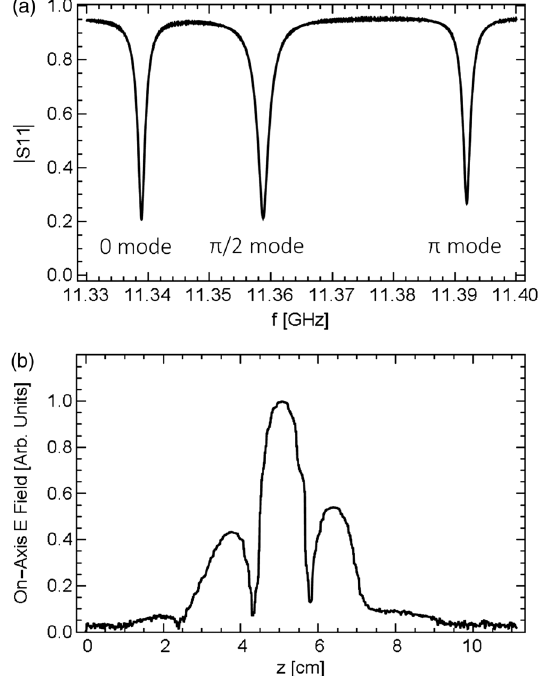
FIG. 7. (a): Measured j S 11 j vs frequency and (b): measured on- axis electric fields for Cryo-Cu-SLAC-#2 both at room temper- ature.